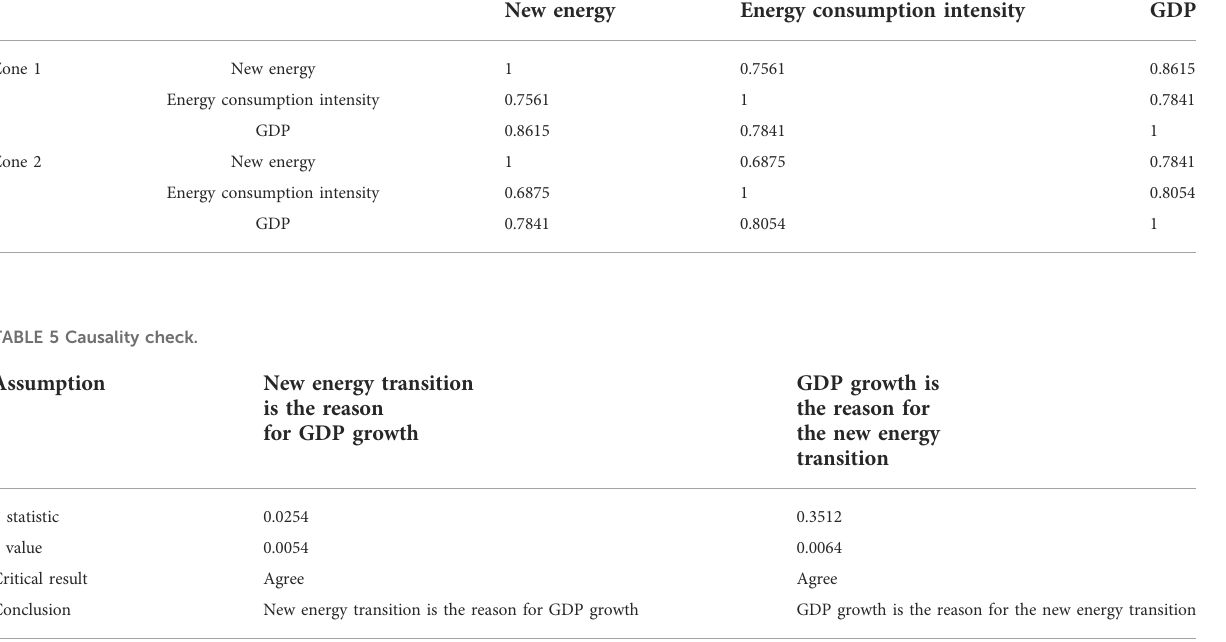
TABLE 4 Correlation coef fi cient